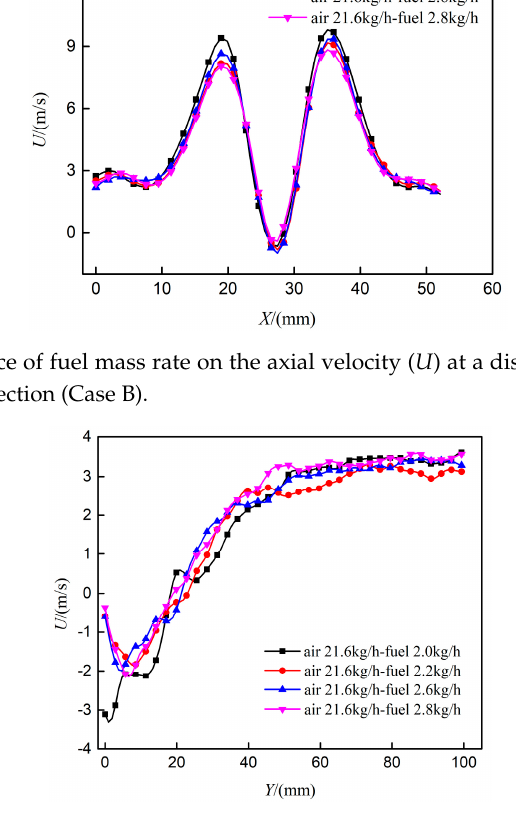
Figure 18. The influence of fuel mass rate on the axial velocity ( U ) at the axis (Case B).